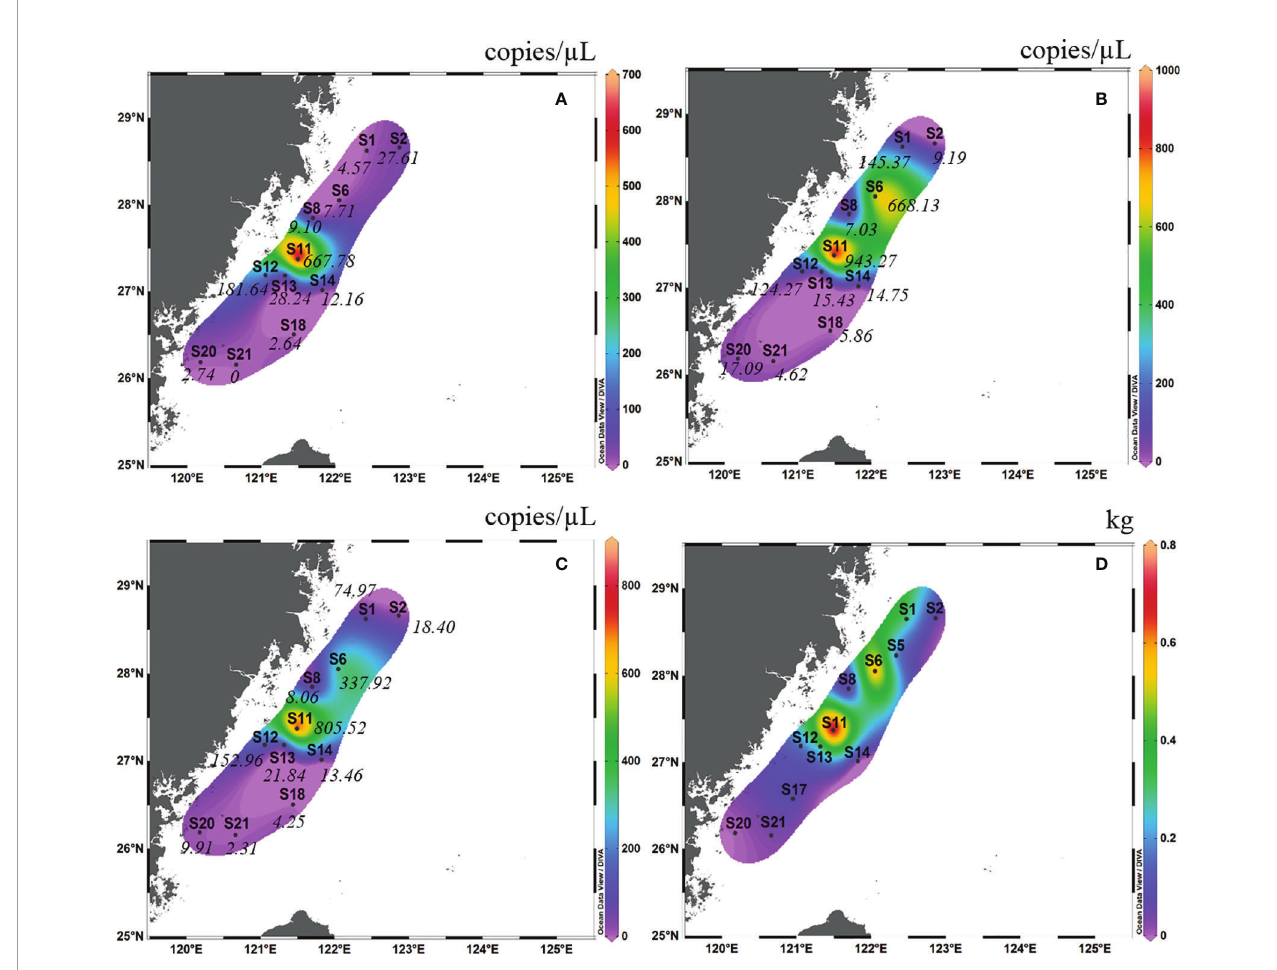
FIGURE 5 | Contour map of Larimichthys crocea in the East China Sea in spring 2019 based on eDNA concentration of real-time qPCR analysis from surface samples (A) , bottom samples (B) and the average between surface samples and bottom samples (C) , and based on capture biomass from fi shing surveys (D) . The italicized numbers indicate the eDNA concentrations of L. crocea